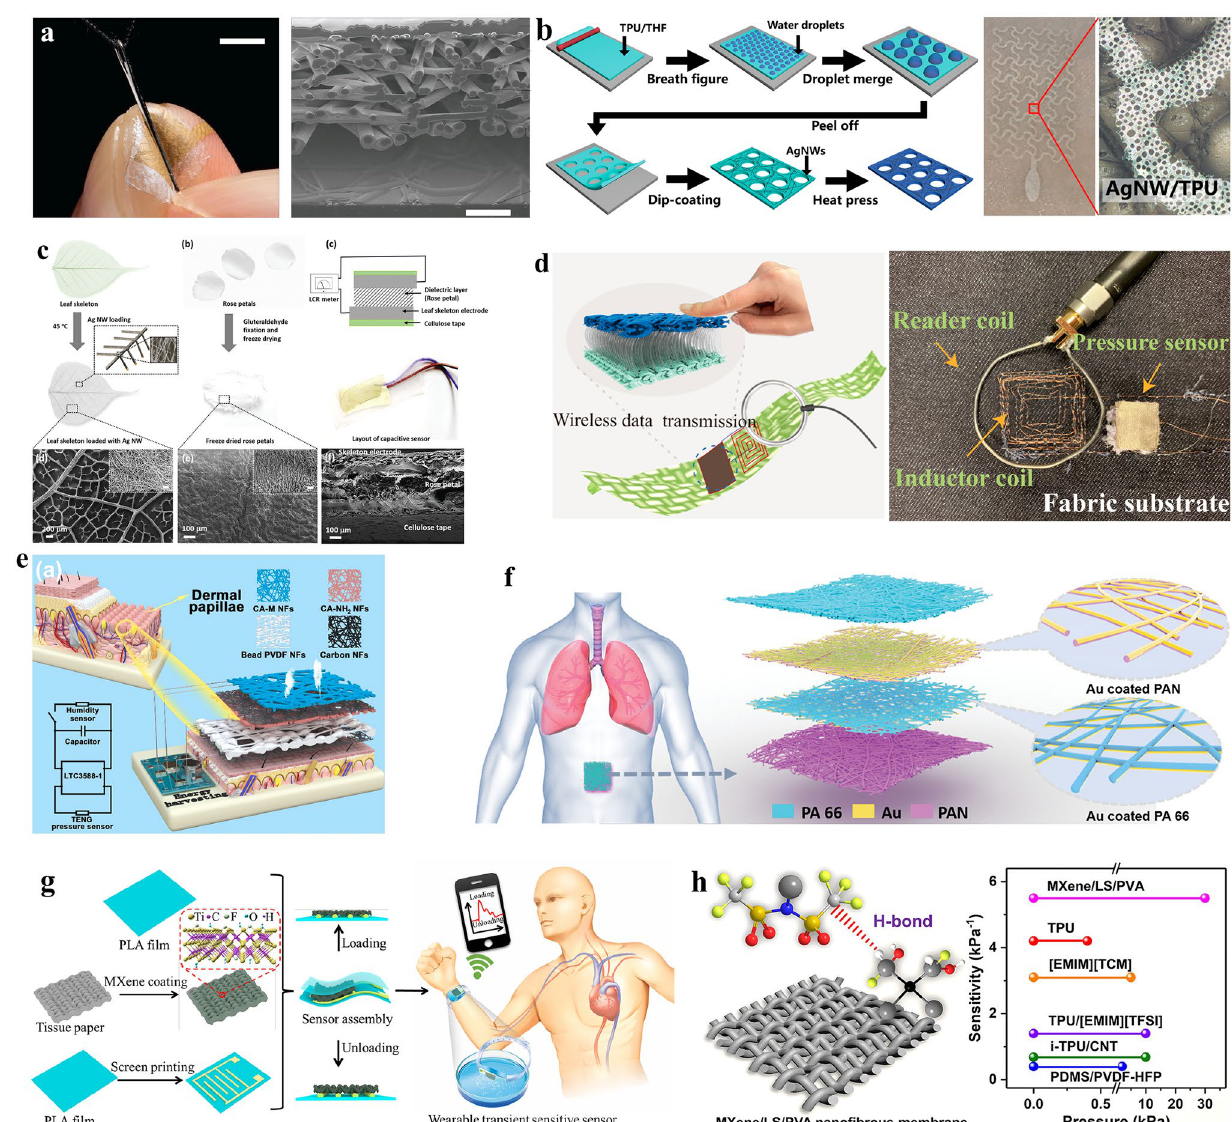
Fig. 3 a Photograph and structure of the nanomesh‑based tactile sensor. Reproduced with permission from Ref. [58]. Copyright 2020 AAAS. b The fabrication process of the porous TPU film and its photographs. Reproduced with permission from Ref. [59]. Copyright 2020 American Chemical Society. c The fabrication process and the structure of the plant‑based body motion detecting e‑skin. Reproduced with permission from Ref. [63]. Copyright 2020 Wiley. d Schematic illustration of the all‑textile body motion detecting e‑skin. Reproduced with permission from Ref. [64]. Copyright 2020 American Chemical Society. e The skin‑inspired respiratory sensor. Reproduced with permission from Ref. [66]. Cop‑ yright 2022 Elsevier. f The structure of the all‑nanofiber respiratory sensor. Reproduced with permission from Ref. [25]. Copyright 2021 Wiley. g The structure of the breathable and degradable pules sensor. Reproduced with permission from Ref. [67]. Copyright 2021 American Chemical Society. h The structure of the hydrogen‑bond‑triggered hybrid nanofibrous pulse sensor. Reproduced with permission from Ref. [68]. Copyright 2021 American Chemical